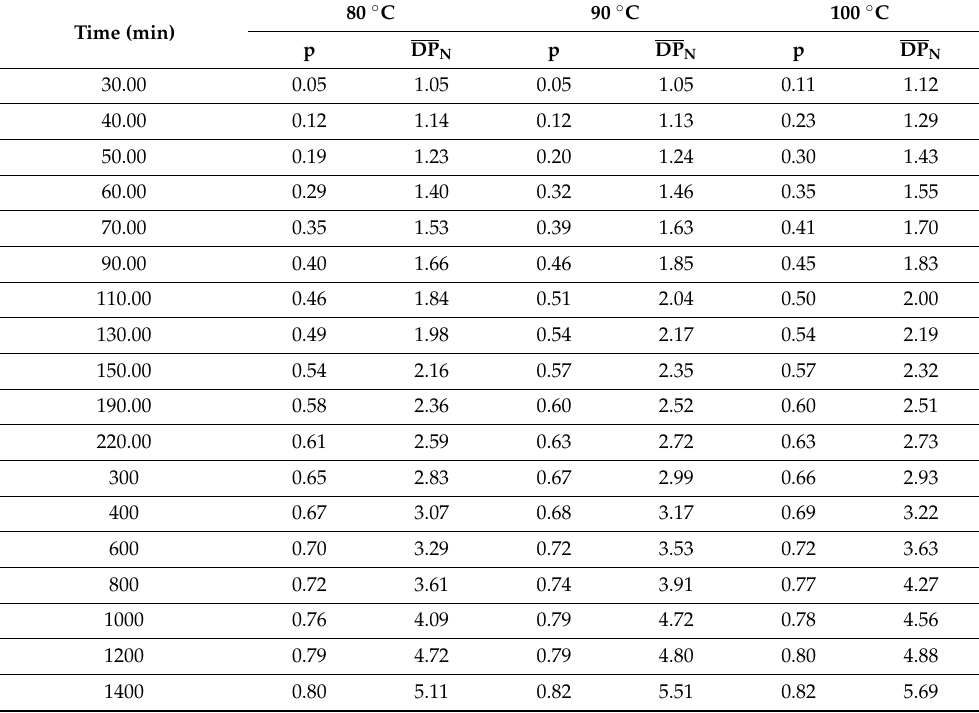
Table 1. The extent of reaction (p) and the degree of polymerization DP N vs. time